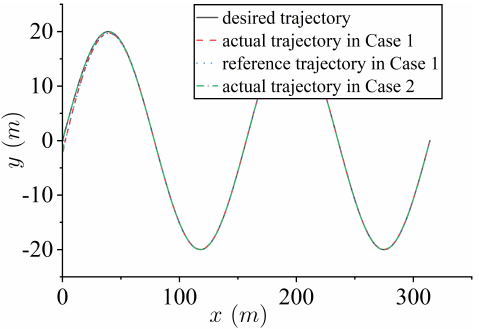
Figure 3. The comparison of trajectories in Case 1 and Case 2.